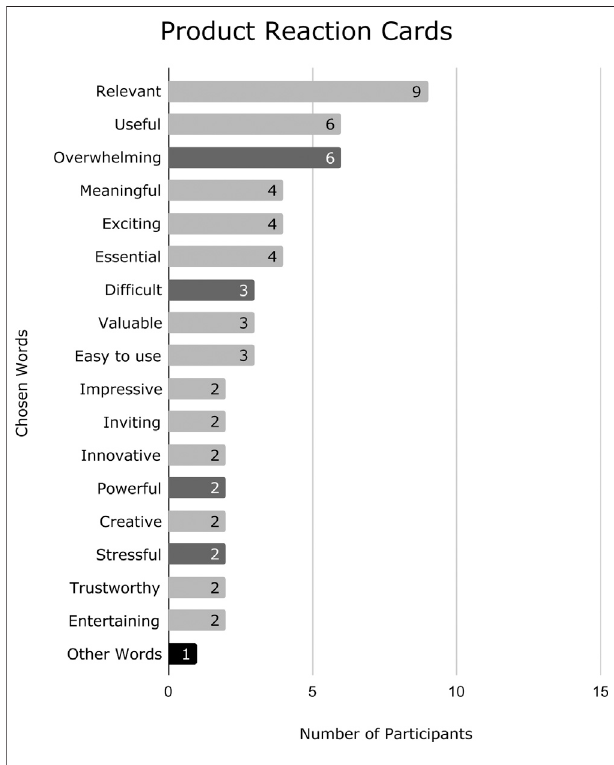
FIGURE14| Frequencydistributionofthewordschosenbyparticipants in the PRC evaluation. Light gray represents positive words and dark gray represents either neutral or negative words. ‘ Other Words ’ comprise Disconnected, Engaging, Expected, Helpful, Inspiring, Intimidating, Intuitive, Straightforward, Optimistic, Compelling, Personal, Collaborative, Fun, Satisfying, Incomprehensible, Not secure, and Effective, which were each chosen